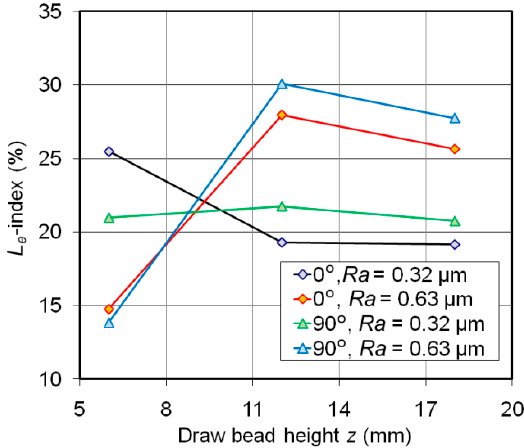
Figure 9. Effect of the draw bead height on the effectiveness of lubrication. Figure 9. E ff ect of the draw bead height on the e ff ectiveness of